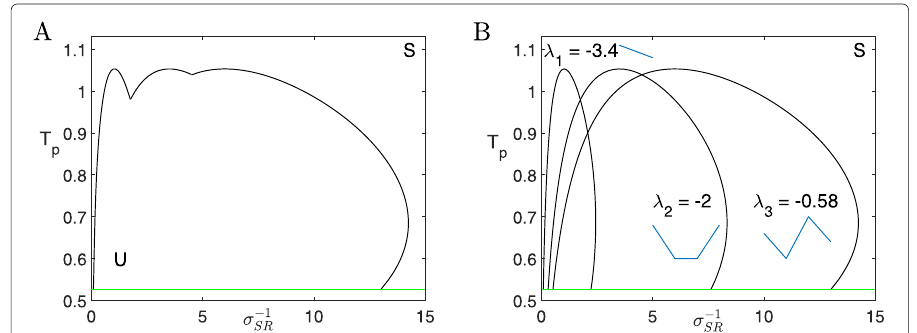
Fig. 4 a Stability region of the synchronous network state as a function of the luminal coupling strength σ − 1 and the pacing period T p for a network of 4 CRUs. The synchronous state is unstable in the region labeled U and stable in the region denoted by S. The green line indicates the pacing period at which the period-1 orbit of a single CRU loses stability. b Stability regions of individual eigenvectors. The corresponding eigenvectors are shown in blue, and the corresponding eigenvalues are listed. The green line is the same as in ( a )